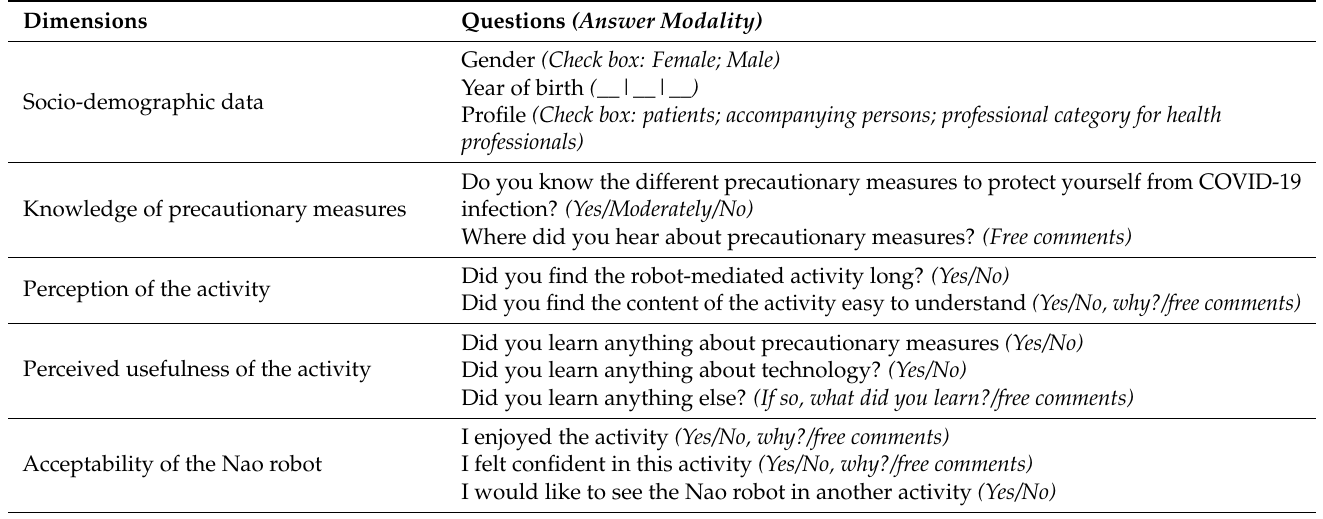
Table 1. Dimensions and related issues addressed in the patient and accompanying persons questionnaire.